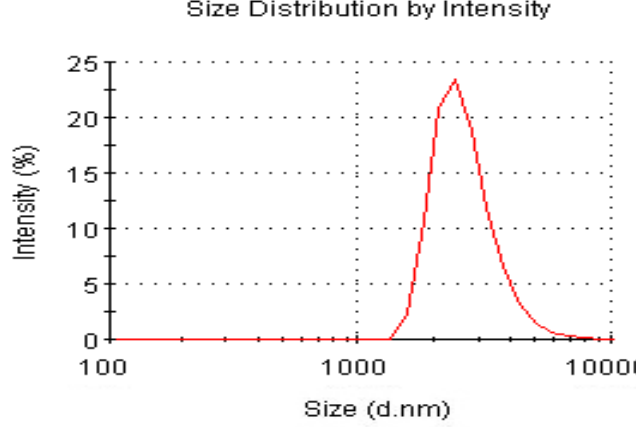
Figure 3. Particle size distribution of